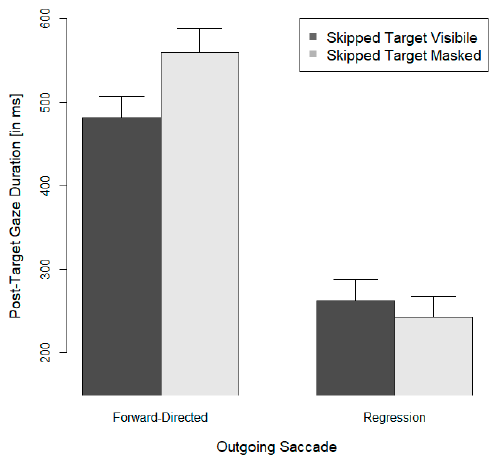
Figure 2. Mean gaze durations and their standard errors for post-target words when the preceding target word had been skipped. Means are shown as a function of the visibility of the target word prior to skipping and of the direction of the saccade out of the fixated post-target word.